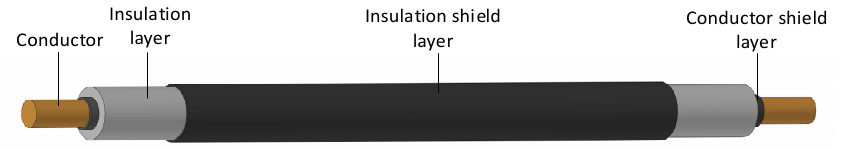
Figure 1. The cable sample.